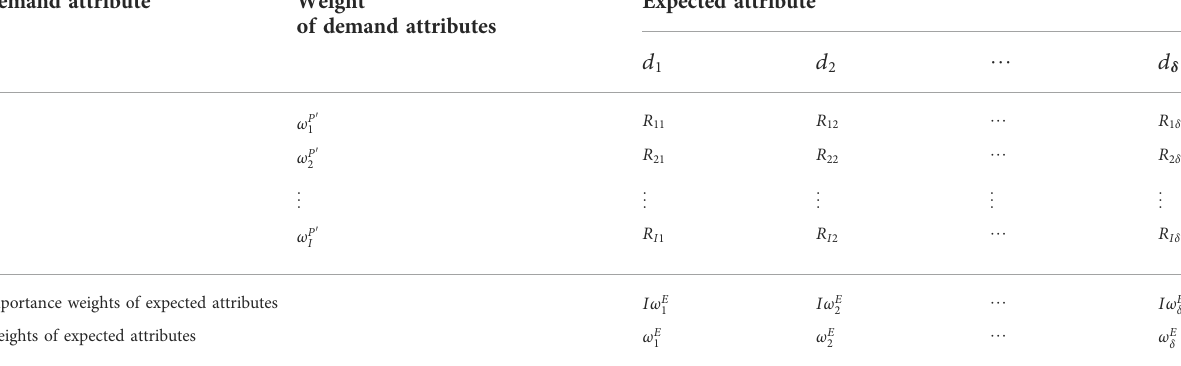
TABLE 3 Relationship matrix between E b and d a